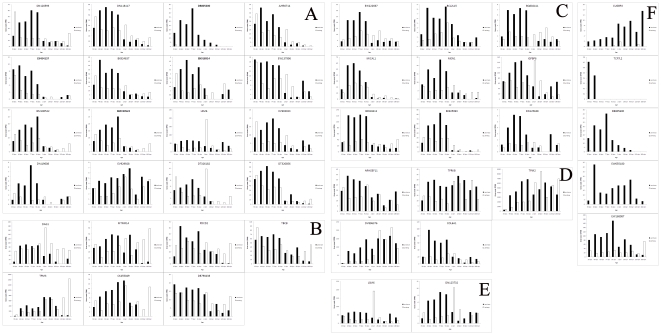
The muscle developmental genes which were higher expressed in LR than in LT.(A) These 13 genes were highly expressed at 35 dpc of the two breeds, and then maintained the high expression in prenatal LR but down regulated in prenatal LT; (B) These 7 genes were similar expressed with MEF2D; (C) These 9 genes were highly expressed in prenatal of the two breeds, but higher expressions were showed in LR than in LT; (D) These genes were differential expressed in prenatal between the two breeds, but showed no differences in postnatal; (E) LSM4 and DN123732 were highly expressed in prenatal LR and 2 dpn of LT; (F) These 5 genes were only highly expressed in LR.